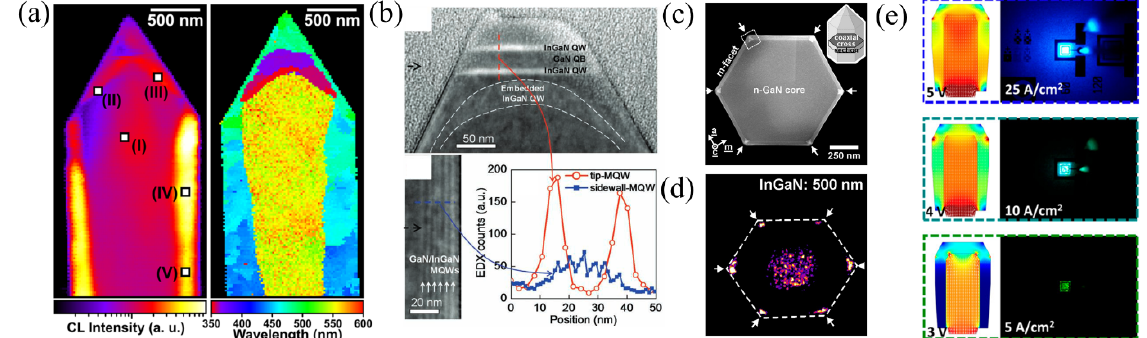
Figure 6. ( a ) CL intensity image (left) and correlated CL peak wavelength image (right) of a microrod. Reprinted with permission from Ref. [2]. Copyright 2016 American Chemical Society. ( b ) TEM images of the InGaN/GaN MQWs on top (top) and on the side (bottom, left) of a microrod. The inset shows an EDX profile of the In content. Reprinted with permission from Ref. [19]. Copyright 2011 WILEY-VCH Verlag GmbH & Co. KGaA, Weinheim. ( c ) HAADF image of a coaxial cross-section of a single microrod. The inset shows a schematic microrod including the cross-section. Reprinted with permission from Ref. [54]. Copyright 2018, Schmidt et al. ( d ) Monochromatic CL intensity image at 18 K and 500 nm of the cross-section. Reprinted with permission from Ref. [54]. Copyright 2018, Schmidt et al. ( e ) Simulation of the current injection from 3–5 V showing the regions of the microrod contributing to the EL spectrum (left) and corresponding EL images (right) of the microrod LED. Reprinted with permission from Ref. [1]. Copyright 2019 American Chemical